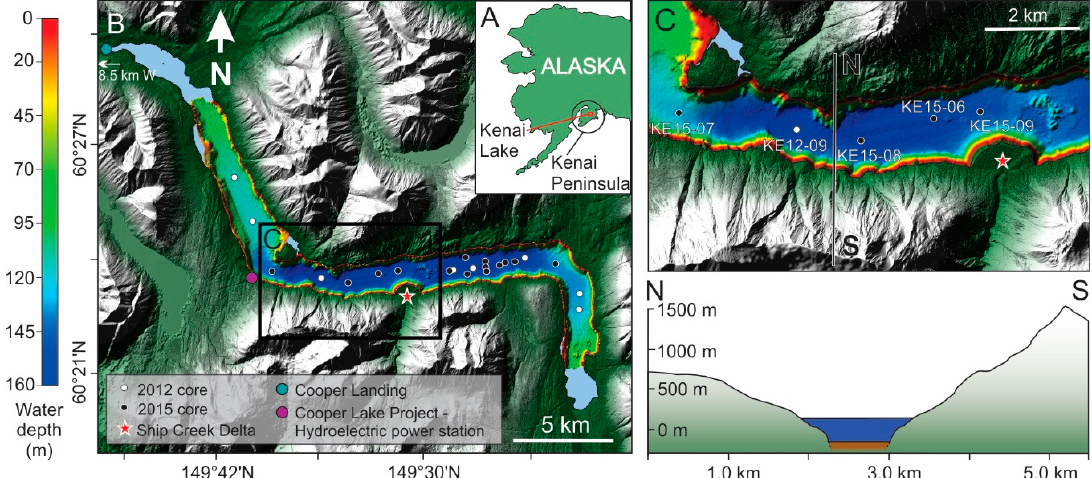
Figure 1. Setting figure of Kenai Lake focussing on the surrounding topography, the bathymetry and the coring locations: ( a ) Map of Alaska showing the location of the study area on Kenai Peninsula. ( b ) Multibeam bathymetry of Kenai Lake on top of a lidar map of the surrounding area [19]. Coring locations of 2012 and 2015 are marked, and villages and deltas are labelled. ( c ) Enlarged western part of the central basin of Kenai Lake with a north-south transect through the central part of the basin.